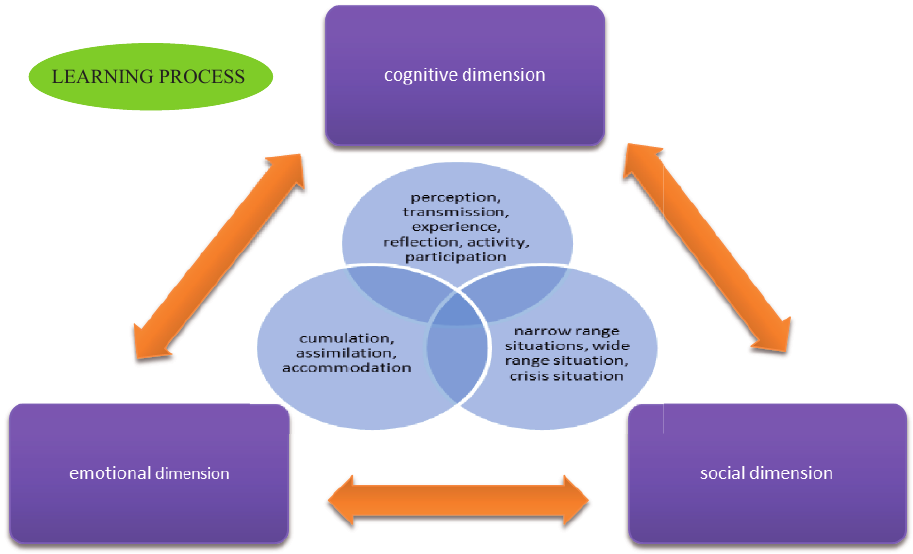
Figure 1. The learning process according to K